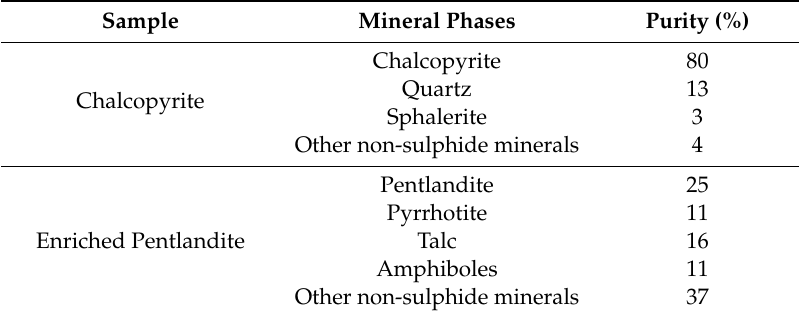
Table 1. XRD analysis of the mineral samples used in adsorption